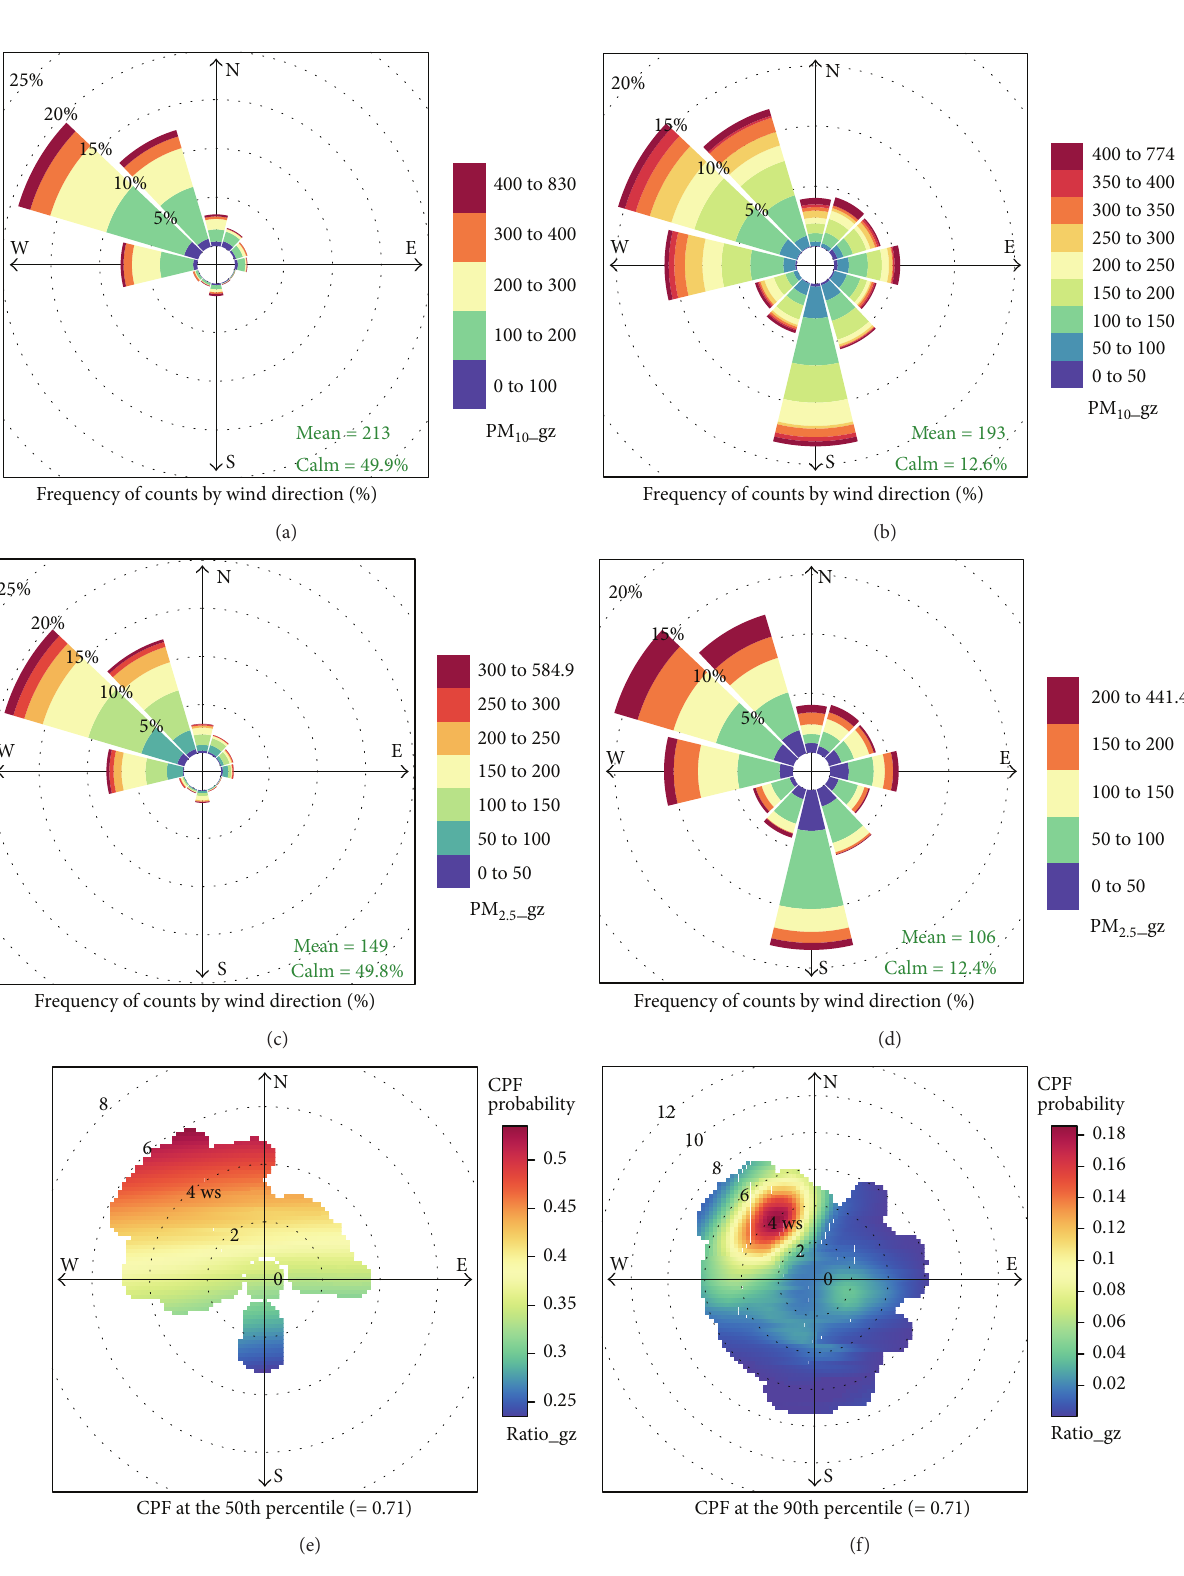
Figure 8: (a) PM 10 pollution rose in winter, (b) PM 10 pollution rose in summer, (c) PM 2.5 pollution rose in winter, (d) PM 2.5 pollution rose in summer, (e) polar plot of PM 2.5 /PM 10 ratio in winter, and (f) polar plot of PM 2.5 /PM 10 ratio in summer at Gazipur